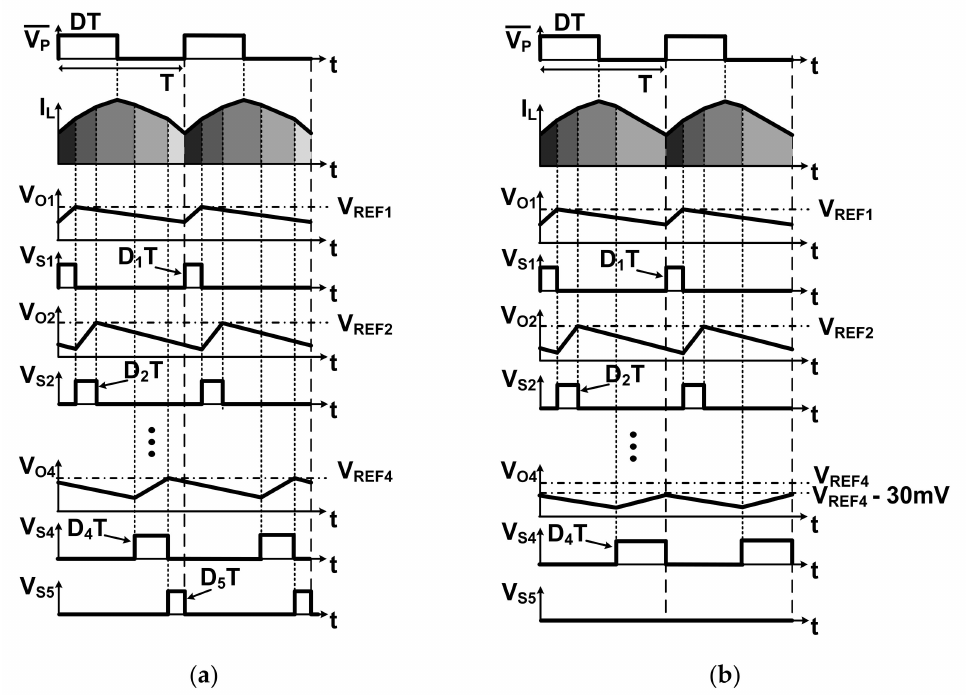
Figure 3. Timing diagram of the proposed SIMO converter ( a ) at energy redundancy state and ( b ) at energy steady